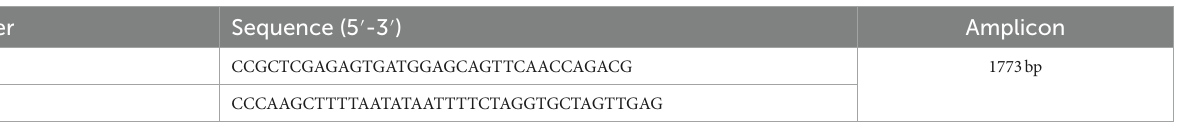
TABLE 1 VP2 primer sequences and amplicon size of CPV.